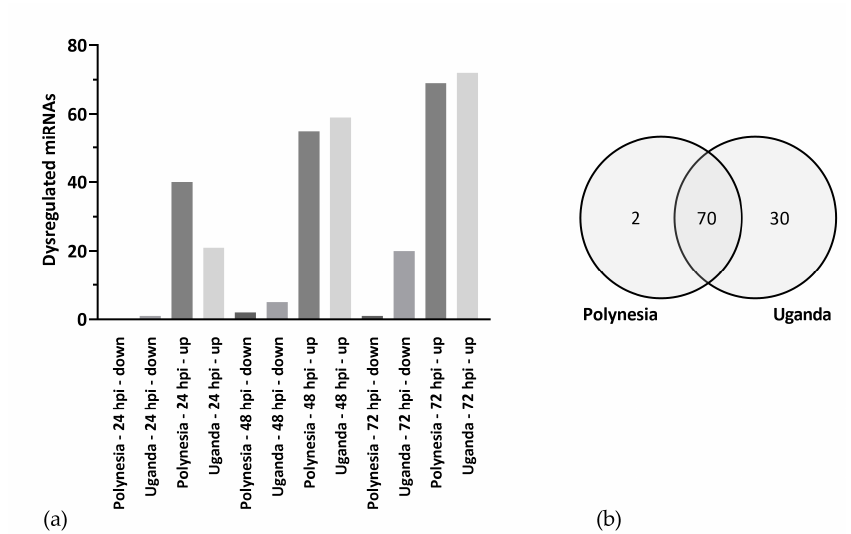
Figure 5. Dysregulated miRNAs. ( a ) Number of more than two-fold, significantly ( p -value ≤ 0.05) dysregulated miRNAs by ZIKV Polynesia and Uganda at 24, 48 and 72 hpi. ( b ) Significantly more than two-fold dysregulated miRNAs by ZIKV Polynesia and Uganda including all time points.